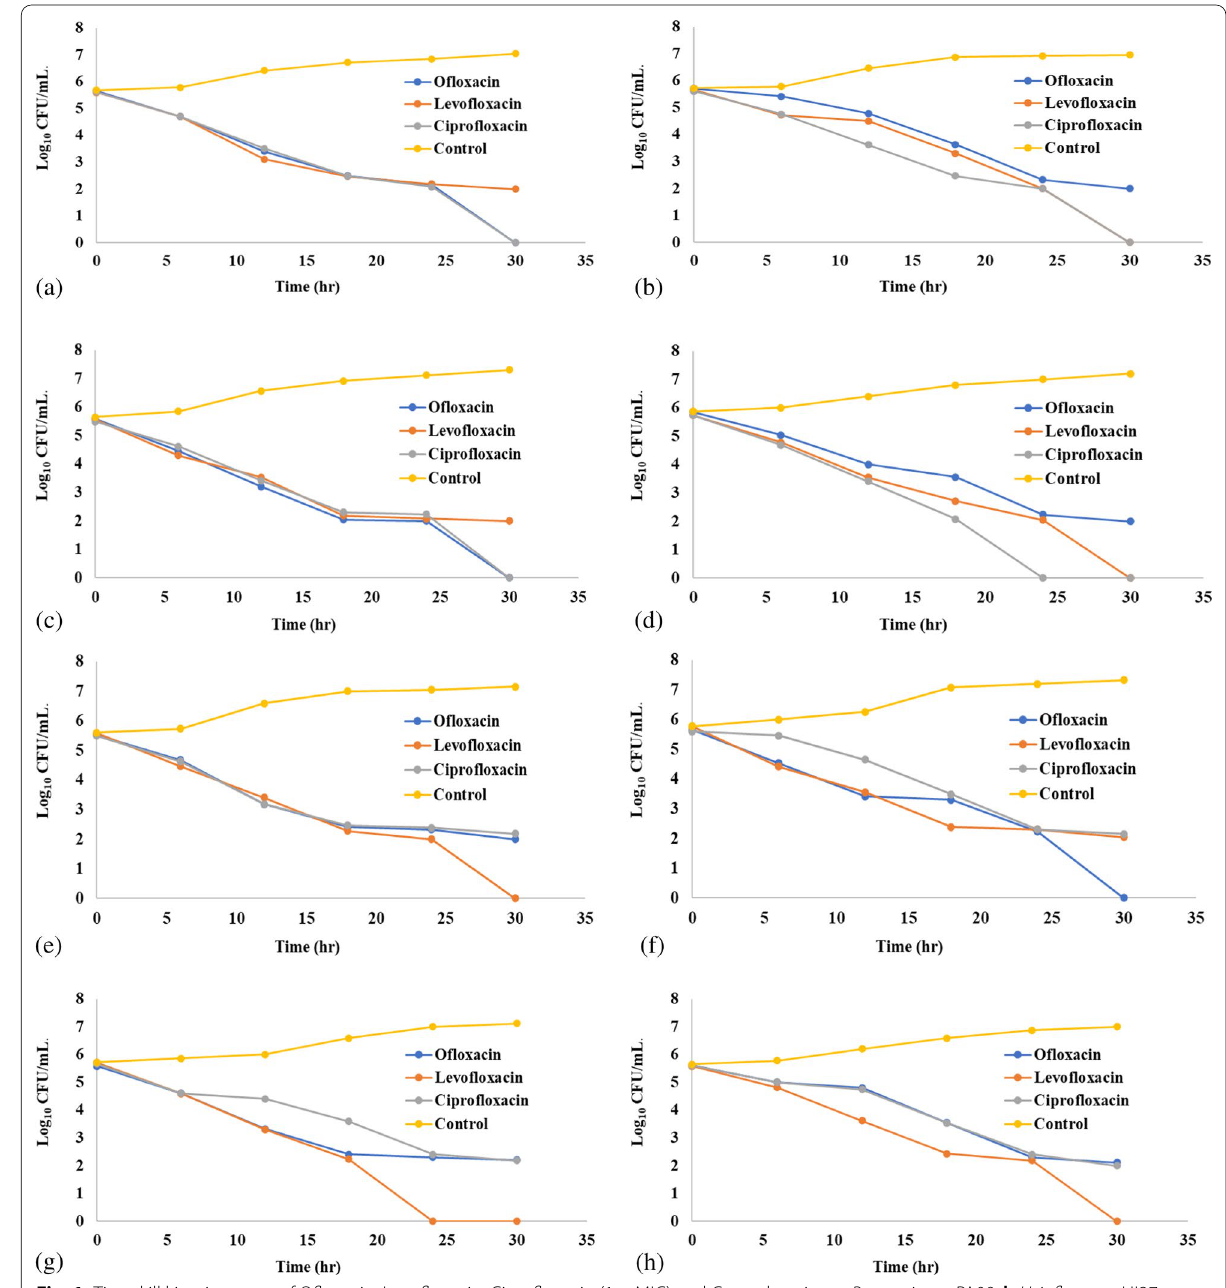
Fig. 1 Time-kill kinetics curve of Ofloxacin, Levofloxacin, Ciprofloxacin (1 Acinetobacter spp AS01, d K. pneumoniae KP32, e S. typhi ST07 f E. aerogenes EA01 g S. aureus SA21 h S. pneumoniae